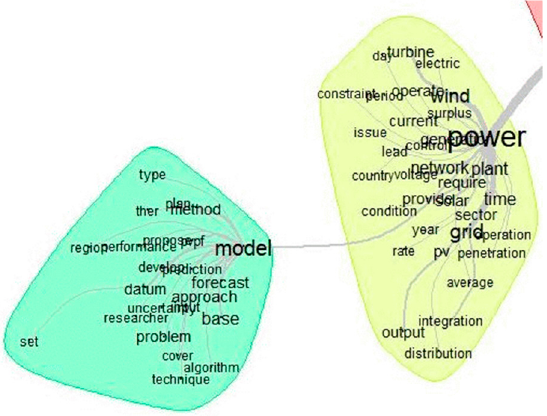
Figure 6. The set of words focused around the word “power”. Source: Own elaboration based on the analysis in the IRAMUTEQ software.